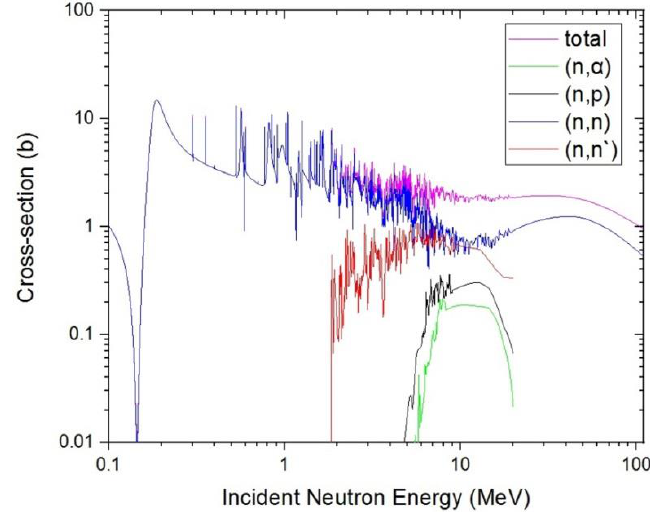
Figure 1. The nuclear reaction cross-section database of neutrons and Si.